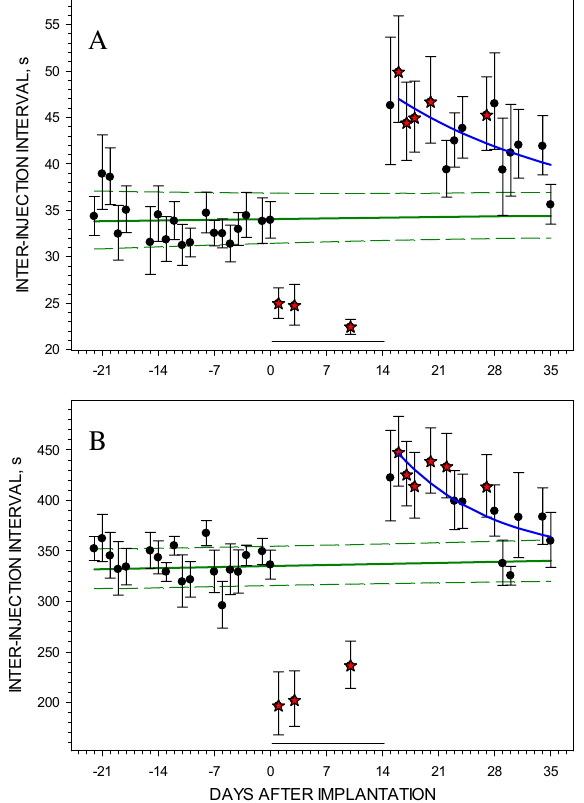
Figure 2. The effect of a 14-day infusion of SCH23390 on the rate of cocaine self-administration. The panels show the percent of baseline inter-injection intervals at a cocaine unit dose of 0.3 µmol/kg (Panel A ) and 3.0 µmol/kg (Panel B ) before, during and after SCH23390 infusion. The green straight lines represent mean interpolated baseline with ± 95% CI from 9 rats indicated by the dashed black lines. Symbols represent mean ± SEM inter-injection intervals, which are not different (closed circles) or statistically different (paired t-test, p < 0.05, red stars) from the projected baseline. The black horizontal lines on the bottom of each panel show the infusion days. The blue curved lines represent the best fit of a mono-exponential regression approximation to the post-infusion inter-injection intervals. Effect decay half-lives were 13.6 days at 0.3 µmol/kg and 8.1 days at 3.0